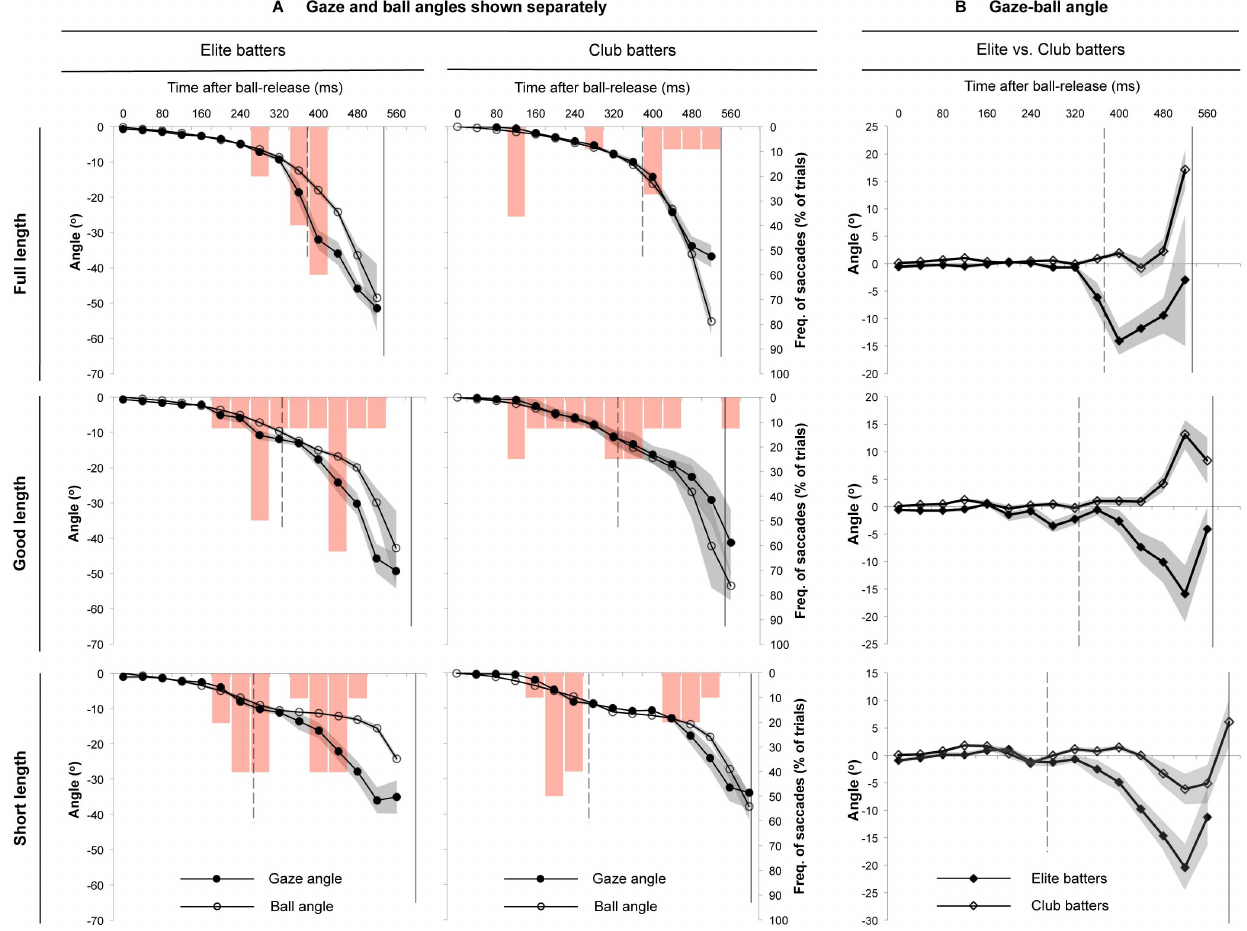
Figure 2. Direction of gaze relative to the ball. Panel A shows, for each combination of level of batting skill and location of ball-bounce, (i) the mean vertical gaze angle and ball angle (black lines with closed and open circles respectively), and (ii) for each time point, the proportion of trials where a saccadic eye movement was initiated ( frequency of saccades ; red columns). Panel B shows the mean vertical gaze-ball angle for each location of ball-bounce. Grey shaded areas represent SE across trials, broken vertical lines indicate the mean time of ball-bounce, and solid vertical lines indicate the mean time of bat-ball contact.